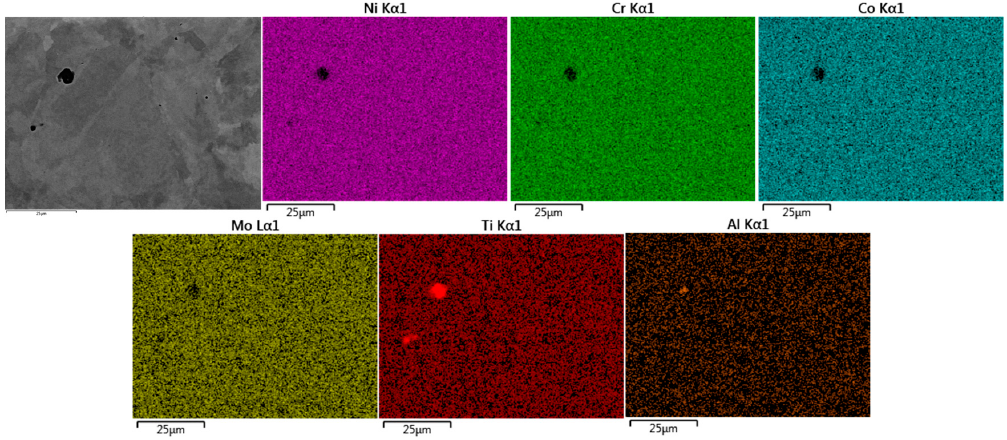
Figure 9. EDS analysis of PB-DLD SHT C263 microstructure.